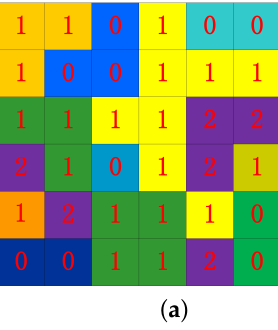
Figure 9. Illustration of the grid clustering result and the spatial indexing structure. ( a ) supposed grid clustering result; ( b ) correspondent spatial indexing